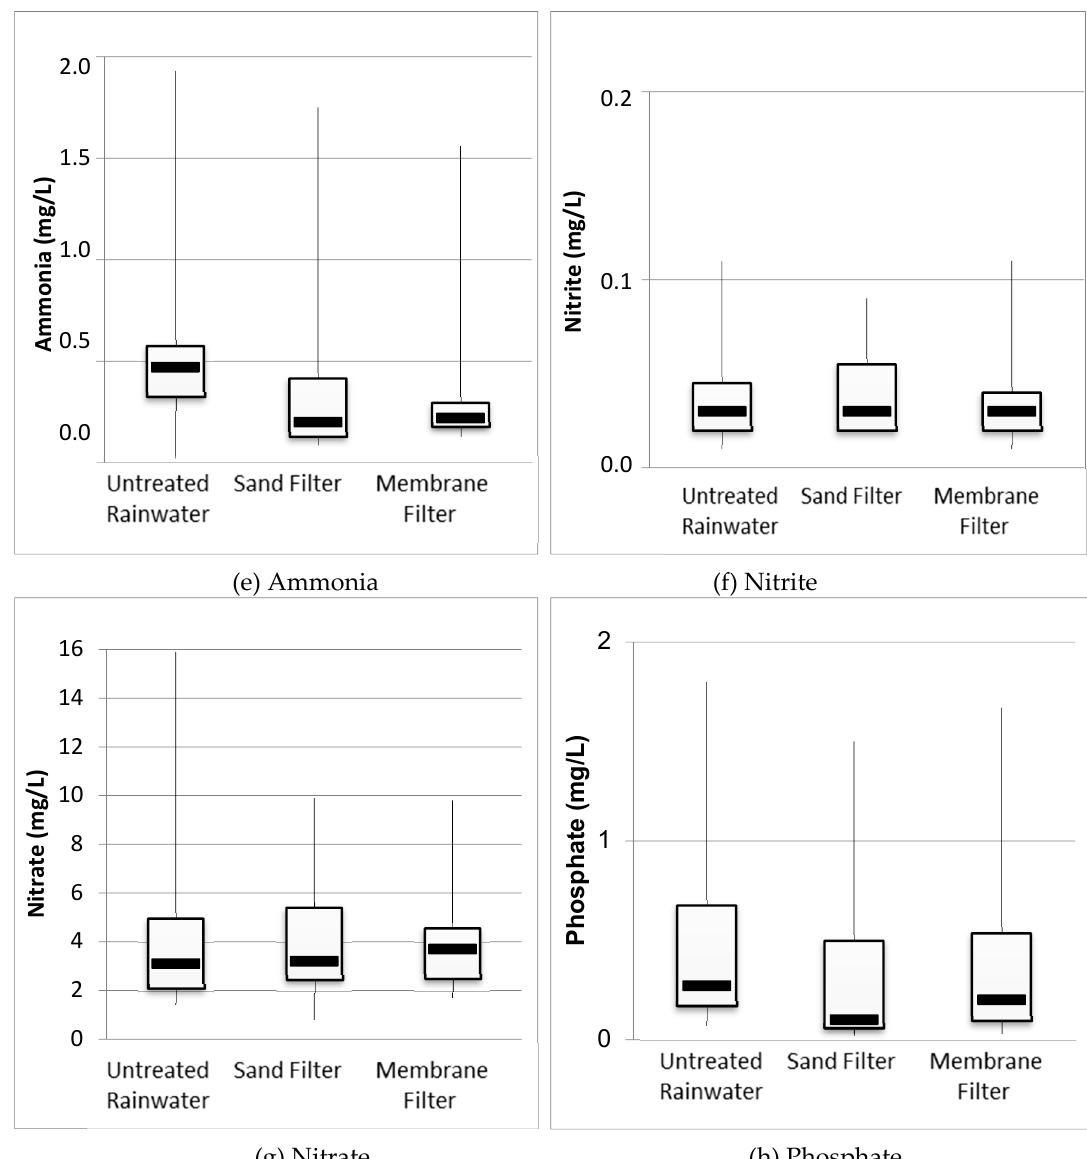
Figure 6 : Box-plot graphs with median, minimum, maximum, 1st and 3rd quarters, and interquartile range of the parameters evaluated.